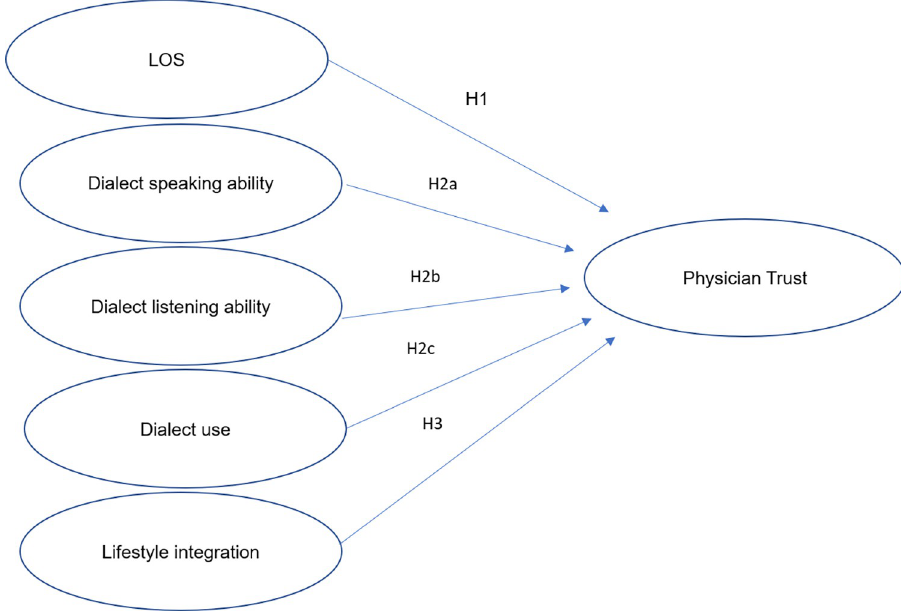
Fig 1. Conceptual model based on immigration acculturation